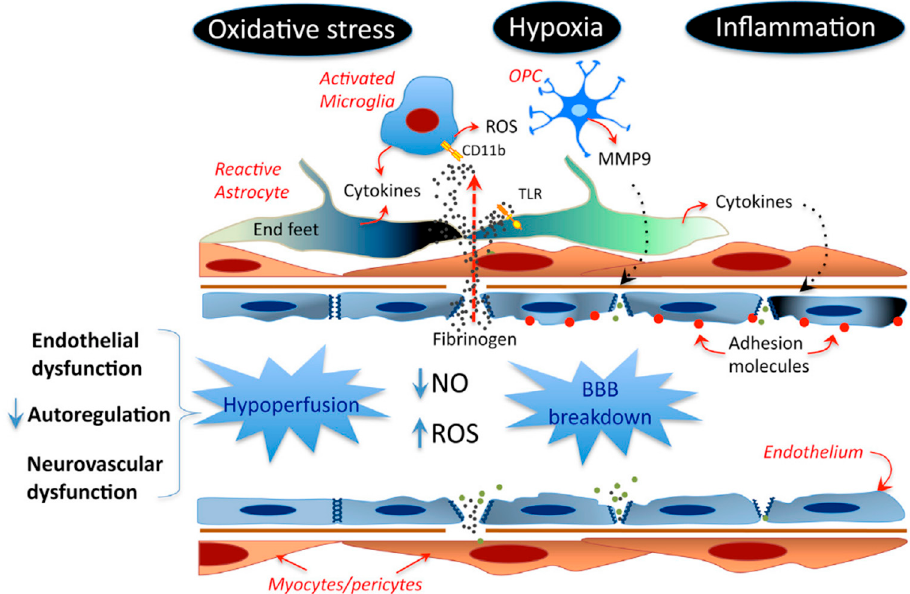
Figure 3. Schema of the BBB/NVU. ECs are shown in blue (lining blood vessels). Inflammatory con- ditions triggered by hypoxia can compromise tight junctions and create openings in the BBB. Sub- sequent entry into the brain of certain compounds such as fibrinogen can activate cells (including microglia and astrocytes) to generate cytokines, amplifying the inflammatory response and poten- tially further compromising the BBB Toll-like receptors (TLRs), matrix metalloproteinase 9 (MMP9),